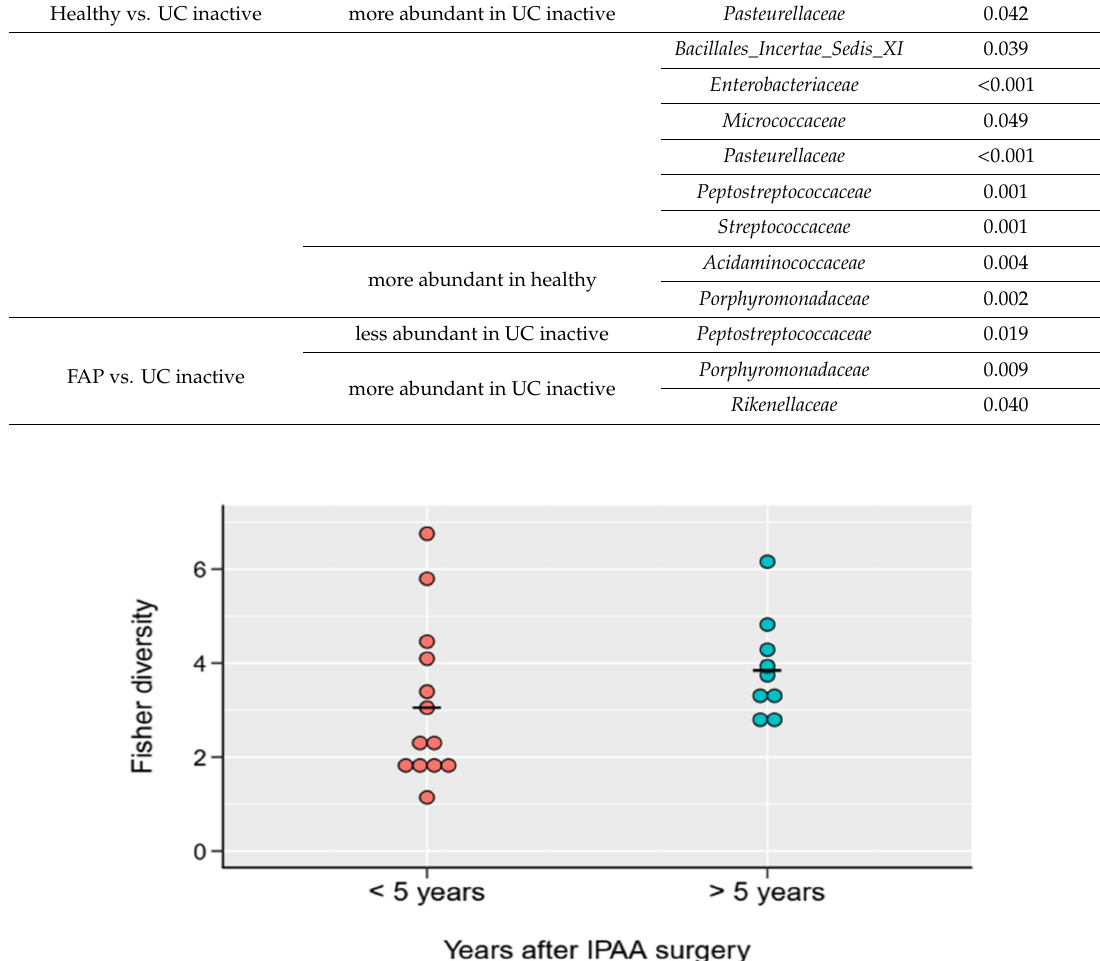
Figure 4. Fisher diversity indices of mature ( > 5 years elapsed after IPAA surgery) and immature ( < 5 years elapsed after IPAA surgery) UC pouch (Pouch) samples. No significant difference was observed between the two groups ( p = 0.2036 from Welch two sample t -test. For details, see Table S5_Patients_ all_ data final).